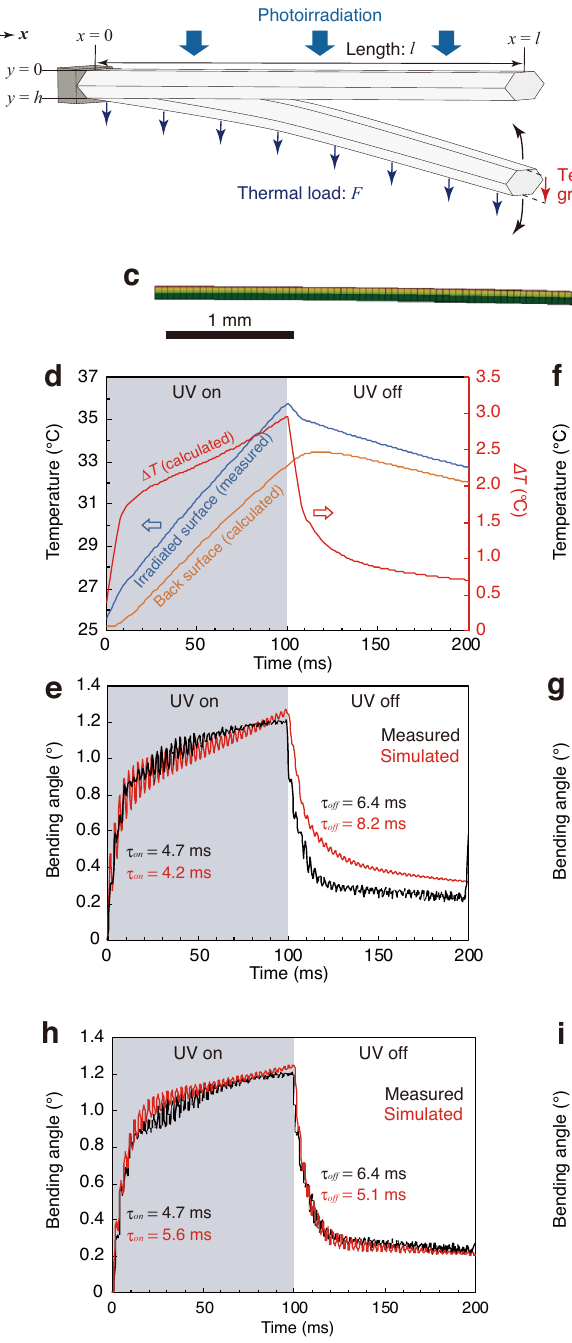
Fig. 5 | Simulation of 1 β crystal III bending by the combination of the photo- thermal effect and the natural vibration. A Simulation I based on the measured crystal surface temperature. a Schematic illustration of crystal bending. b , c Simulated temperature distribution after UV laser irradiation for 100ms: the (100)cross-section( b )andthesideviewofthebentcrystal( c ). d Timedependence of the top surface (blue, measured) and back surface (orange, calculated) tem- peratures and the temperature difference between the two surfaces ( Δ T , red, cal- culated) with and without UV light irradiation for 100ms. e Time pro fi les of measured (black) and simulated (red) bending angles with and without UV light